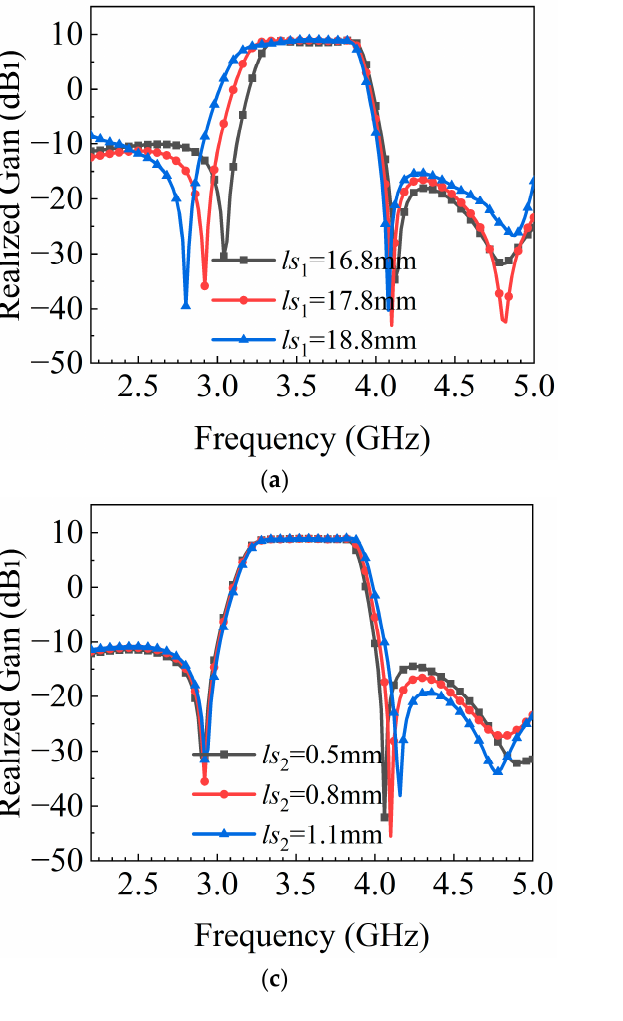
Figure 9. Simulated gain for different parameters . ( a ) ls 1 ; ( b ) wp 2 ; ( c ) ls 2 ; ( d ) ws 3 . Table 1. Optimized antenna dimension. (Unit: mm).